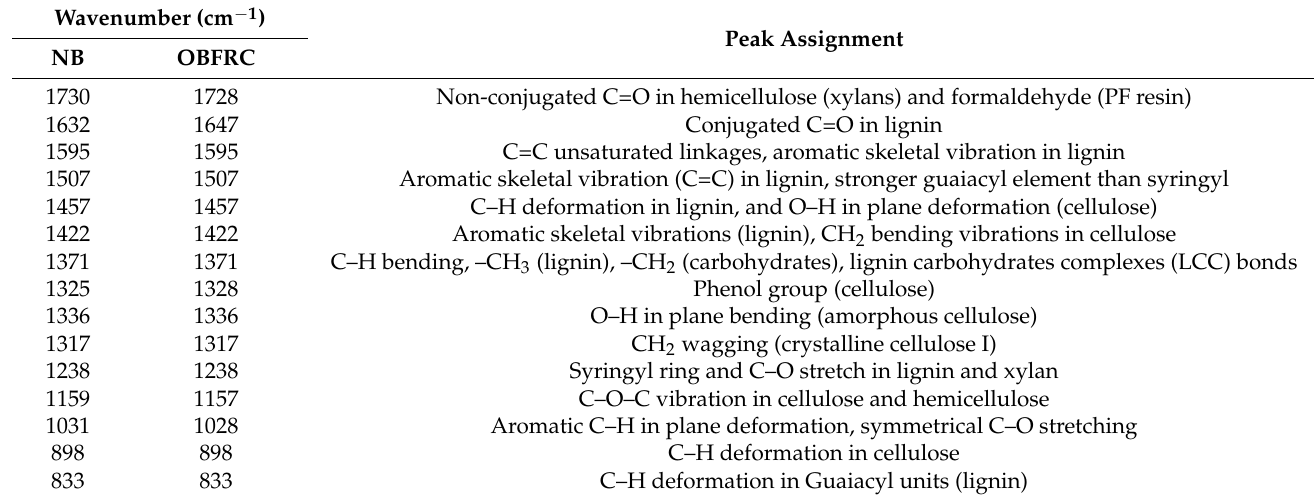
Table 2. Summary of characteristic peaks in the 1800 cm − 1 –800 cm − 1 region of FTIR-ATR spectra for NB and OBFRC